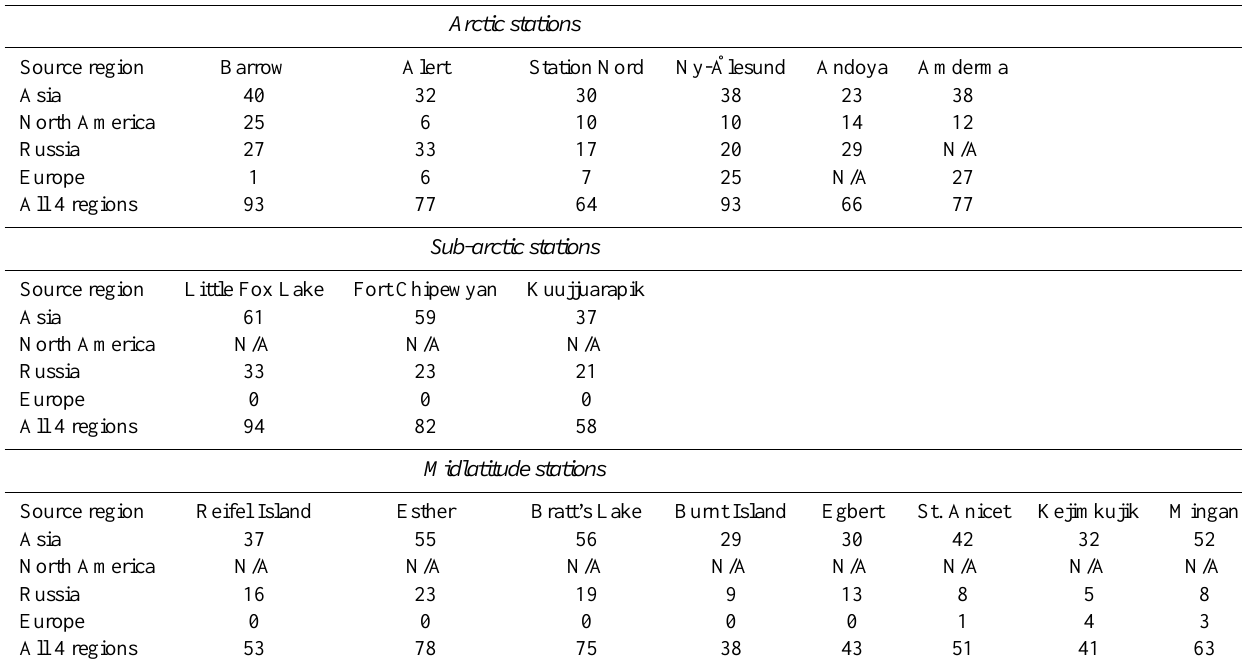
Table 3. Distribution of LRT events by